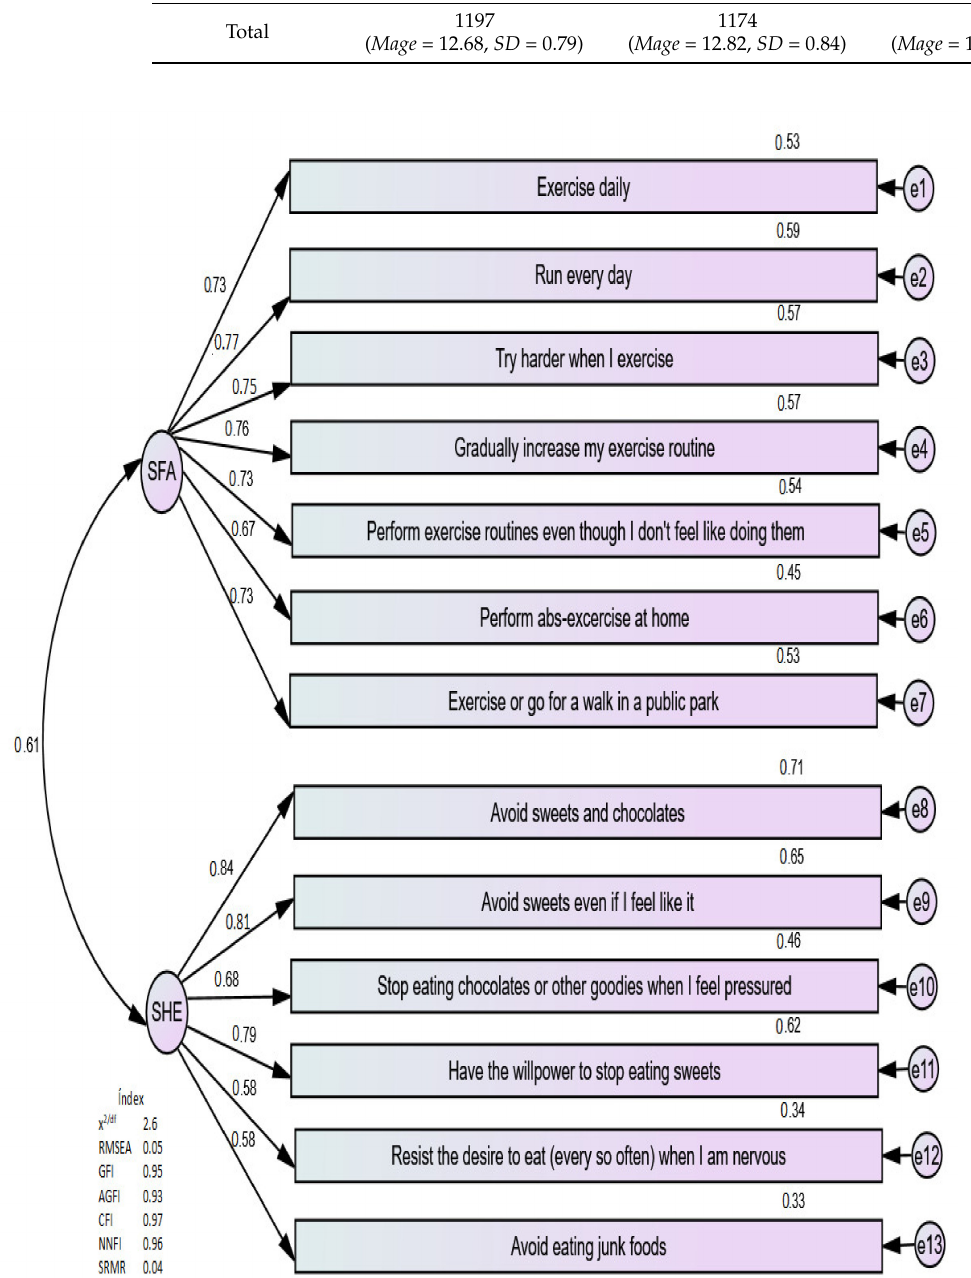
Figure A1. Confirmatory boys